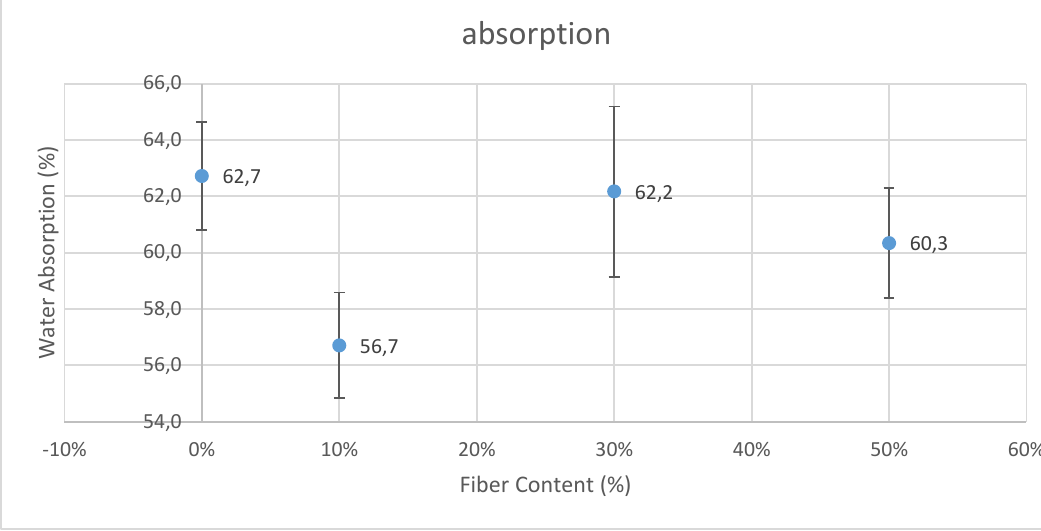
possiblechangeinphysicalparameters-otherwiseabuild- ing disaster may occur during a fire. Compressive and flex- ural stregth testing will give an answer as to whether the material will continue to withstand when exposed to high